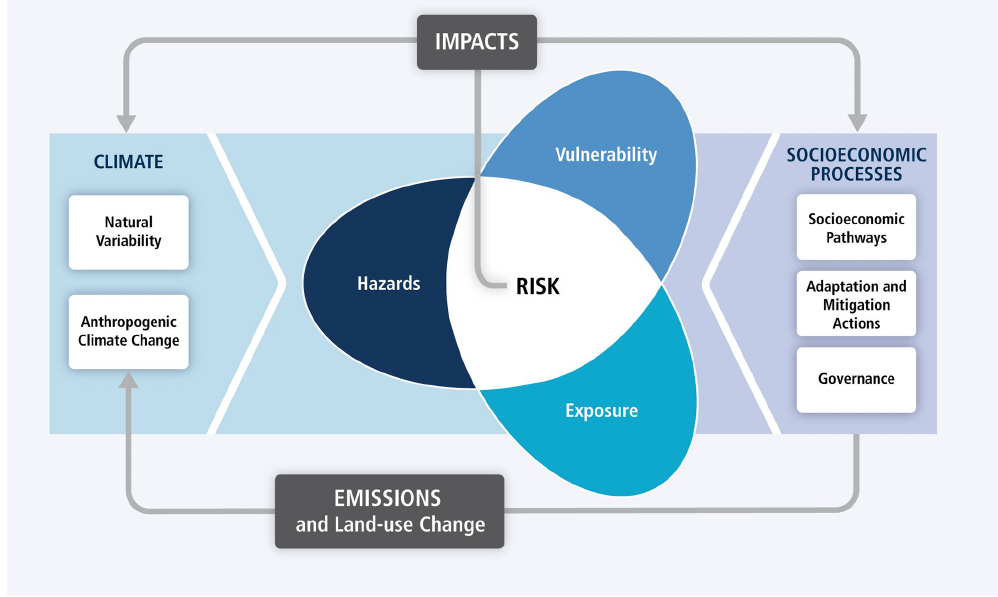
Figure 1. Illustration of the core concepts of Working Group II of the fifth assessment report of the IPCC (IPCC,